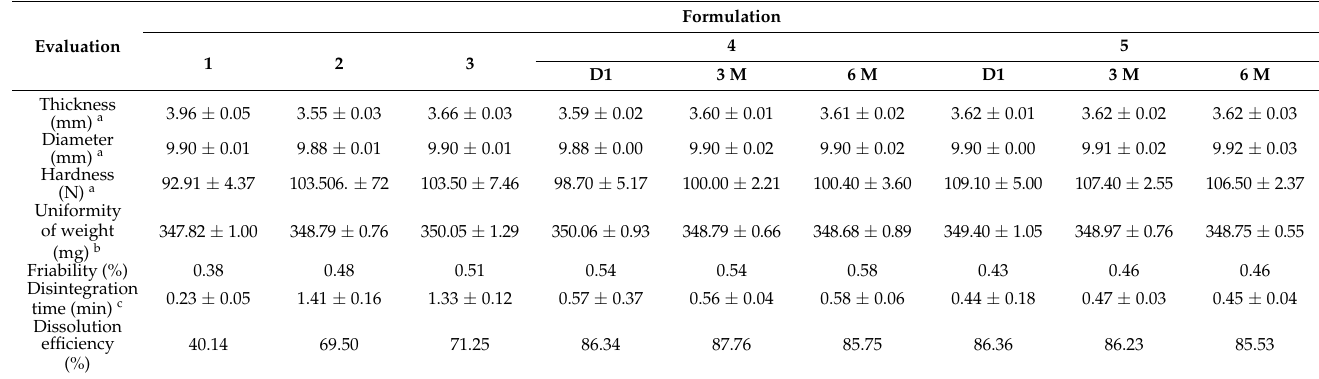
Table 3. Evaluation of paracetamol tablets and stability study results of Formulations 4 and 5 after 3 months and 6 months of storage at conditions 40 ± 2 ◦ C/75 ± 5%